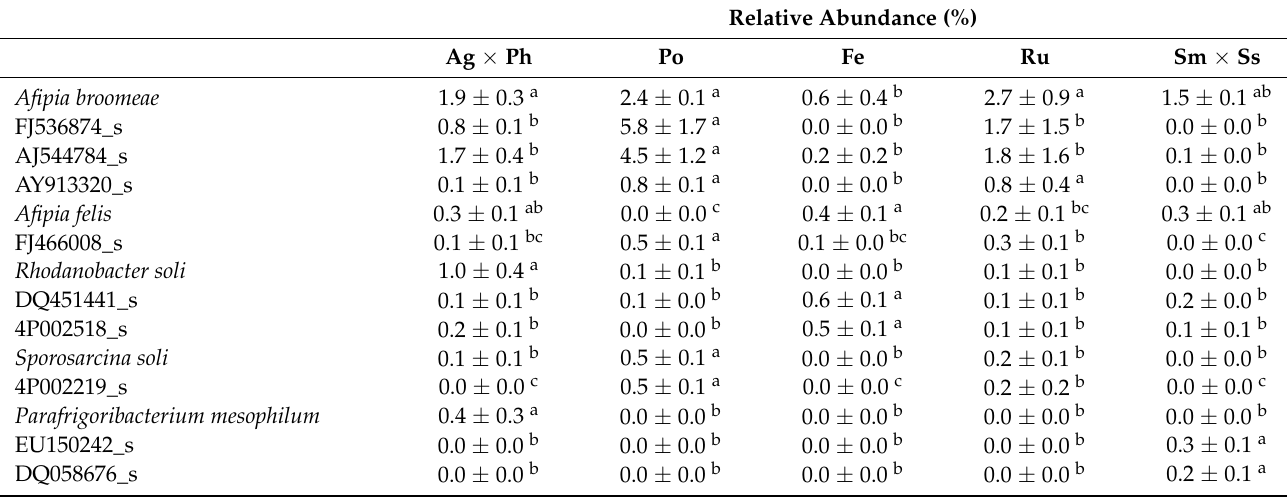
Figure 6. Relative abundance of 15 major bacterial genera showed significant difference and its correlation with soil chemical properties. ( a ) Relative abundance of bacteria; ( b ) Spearman’s correlation coefficient. Ag × Ph, A. alba × P. pratense ; Po, P. pratensis ; Fe, F. ovina ; Ru, R. acetosella ; Sm × Ss, S. miyabei × S. salicifolia . Different letters in the same row indicate significant differences according to Tukey test ( n = 3, p < 0.05). *, **, and *** indicate significant correlation at p < 0.05, p < 0.01 and p < 0.001, respectively. Table 4. Relative abundance of 14 conspicuous bacterial OTUs at the species